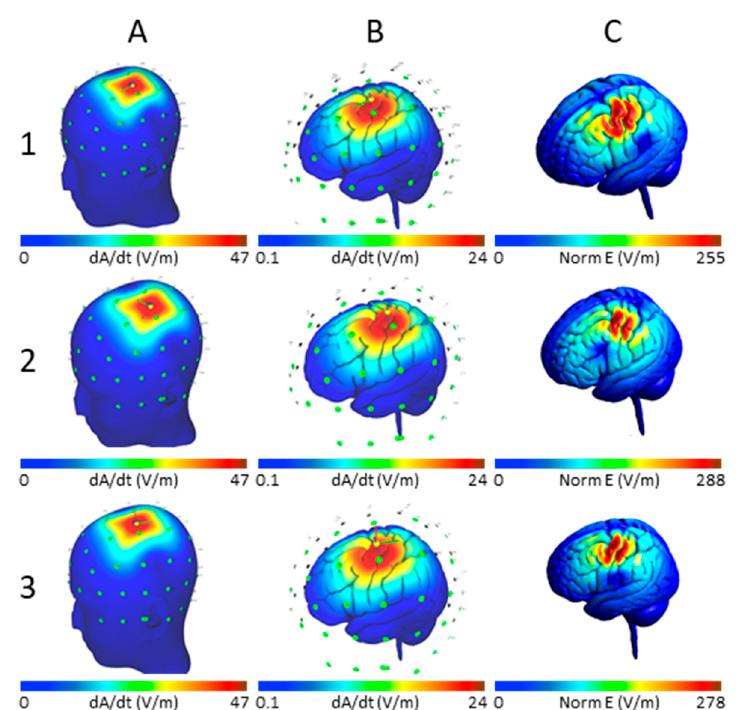
Figure 6. Input and output E-field distributions with TMS coil at position BA 4 and dI / dt = 150 V / m. Coil orientation: Row 1 —Pointing to Nz, Row 2 —Pointing to FCz, Row 3 —Pointing to Oz; E-Field Distribution: Columns: Initial estimation of induced E-field (dA / dt) for the given coil type, position and E-field input superimposed on the scalp (column A ) and cortical surface (column B ); Distribution of the final modeled maximum E-field (Norm E-field) on the cortical surface (column C ). Though the initial estimation of E-field is the same irrespective of coil orientation, the FEM modeled output E-field magnitude and distribution are influenced by the direction of the TMS coil.